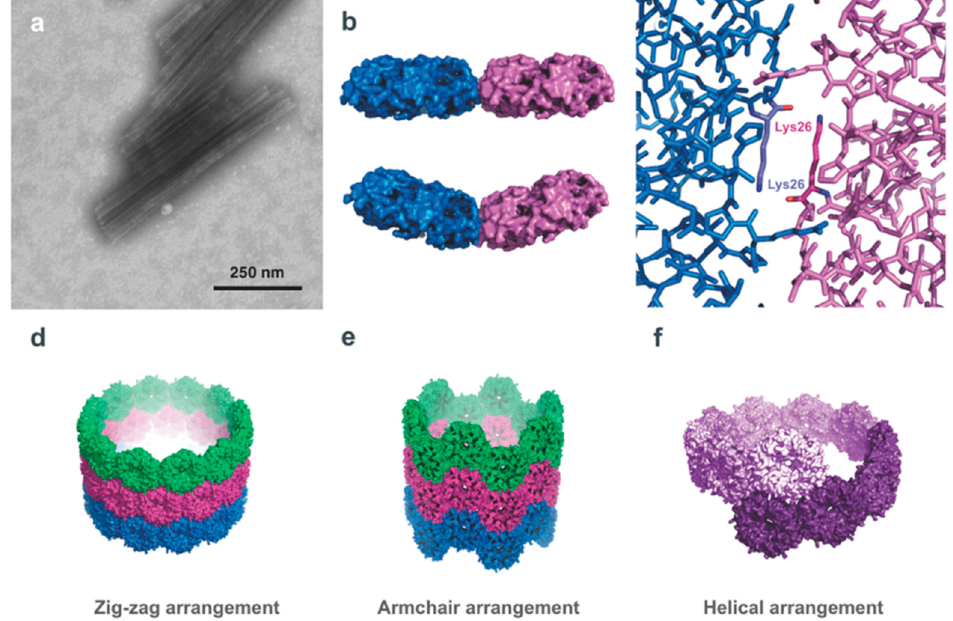
Figure 6. PNTs formed by the microcompartment protein PduA. ( a ) TEM image of PduA nanotubes, which indicate a consistent 20 nm diameter (lengths have been observed to differ). ( b ) A top-down view of two adjacent PduA hexamers (PDB ID 3NGK [95]) illustrating the hexamer–hexamer interface, at bend angles of 0° (top) and 36° (bottom). ( c ) Close up view of the PduA hexamer interface, highlighting the antiparallel arrangement adjacent Lys26 residues, held together by hydrogen bonding. It is this interaction that is critical for PNT assembly. ( d – f ) The three models of PduA PNTs: zig-zag, armchair, and helical, respectively. All three models result in a consistent 20 nm PNT diameter, though modelling suggests that the zig-zag or helical models of PduA PNT assembly more likely than an armchair assembly. All models present the convex face of the PduA hexamer, and importantly the N-terminus of the PduA monomer, to the exterior surface; this can allow the protein engineering of the N-terminus of the protein for surface display of a variety of moieties. (Figure adapted from Uddin et al. Small 14 , 1704020 (2018) [21], under the Creative Commons Attribution Licence).